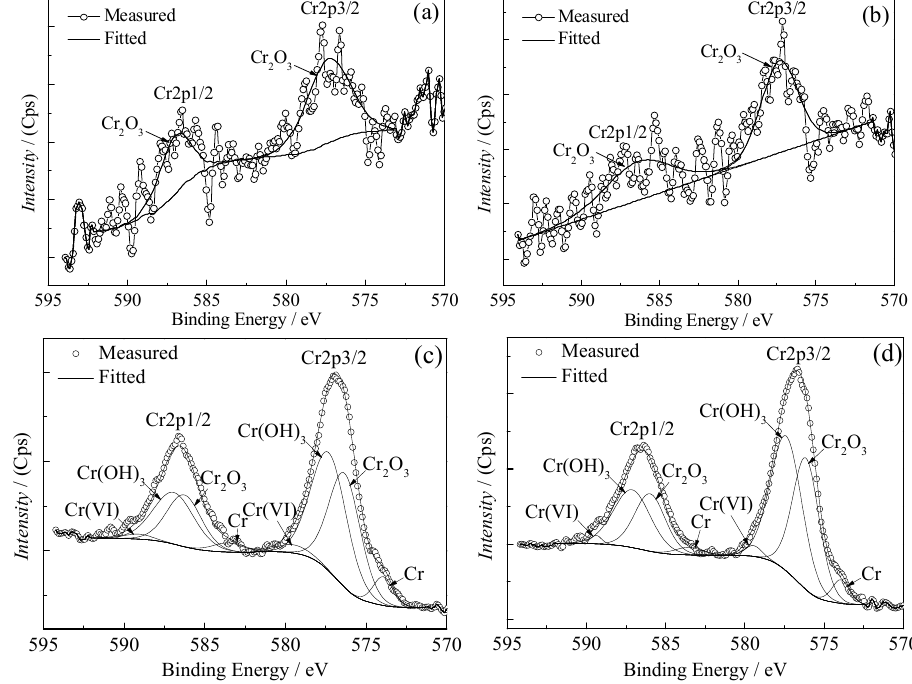
Figure 13. Cr2p peaks measured by XPS and fitted curves of Cr2p peaks for the passivation films obtained via ( a , b ) chemical passivation for 3 s and 6 s, respectively, and ( c , d ) electrolytic passivation for 3 s and 6 s, respectively. Table 6. Binding energy (eV) of the fitting Cr2p peaks and composition of the passivation films obtained through different processes.